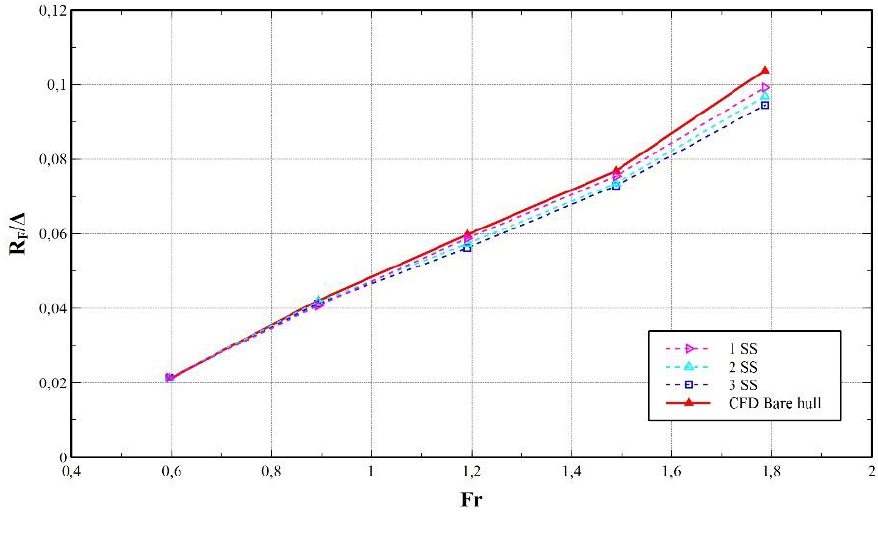
Figure 10a represents one component of total resistance, namely frictional resistance revealed by the non-dimensional units of Rf/ ∆ . At the same time, Figure 10b was the WSA or a component related to frictional resistance. These figures can be concluded that the number of strips increased can reduce frictional resistance and WSA, due to the reduction in the wetted surface and the associated reduction in viscous resistance, while the rest is due to the backward deflection of the spray. The volume fraction approach was used to obtain WSA. The water-air flow is simulated by applying the volume of fraction scheme, which varies between 0 (air) and 1 (water). WSA is estimated using Volume friction of water, which is Volume friction of water value > 0.5 is considered a wetted surface area. Otherwise, the Volume friction of water < 0.5 is considered air. A high-speed planing craft will experience significant changes in wetted surface area with changes in speed. The accurate measurement of running wetted area and estimation of frictional resistance is the basis for resistance analysis. Figure 10a shows that as the speed of planing increases, the wetted length and, consequently, the wedge volume decreases rapidly, and the lift becomes mainly dynamic. The percentage reduction in WSA due to the addition of strips to the WSA bare hull was 6.4% for three strips, 5.2% for two strips, and 3.6% for one strip. The frictional resistance of the three rails shows the highest reduction in drag force. In general, the ship’s resistance components are divided into two parts, namely residual resistance and frictional resistance. In this study, the discussion will only be conducted on frictional resistance because frictional resistance is easier to predict than residual resistance. Frictional resistance is related to the hull’s wetted surface area. A planing hull vessel shows that the WSA is very high at low speeds and gradually decreases at high speeds. It shows that the hydrostatic force acting at the center of pressure on the hull is smaller than the pressure force over the wetted surface.